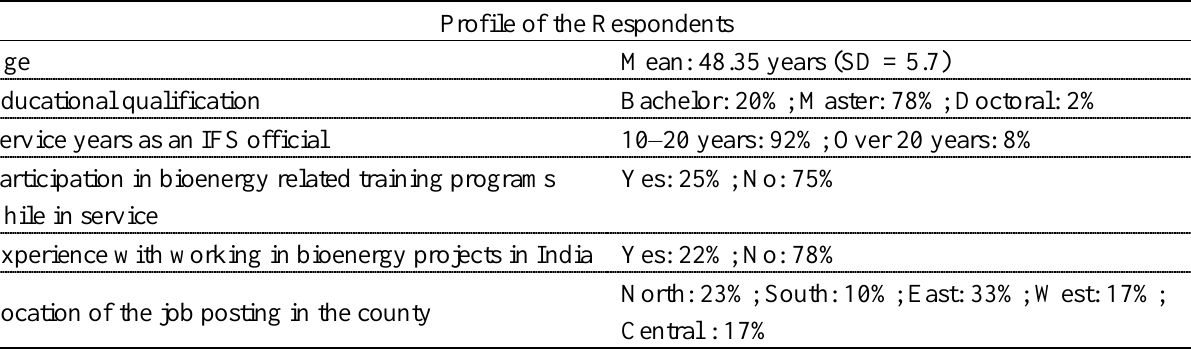
Table 1. Respondents’ educational and work related profiles ( N = 55).